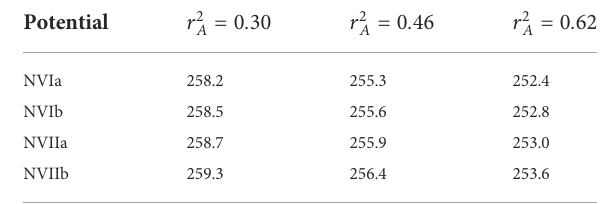
TABLE 4 Total doublet capture rate in the 1 S 0 nn channel, Γ D ( 1 S 0 ) in s − 1 , is calculated using all the different interactions and consistent currents up to N3LO, and three different values of r 2 r 2 (cid:2) 0 . 30 , 0 . 46 , 0 . 62 fm 2 . The variational method is applied to A , A calculate the deuteron and the nn scattering wave